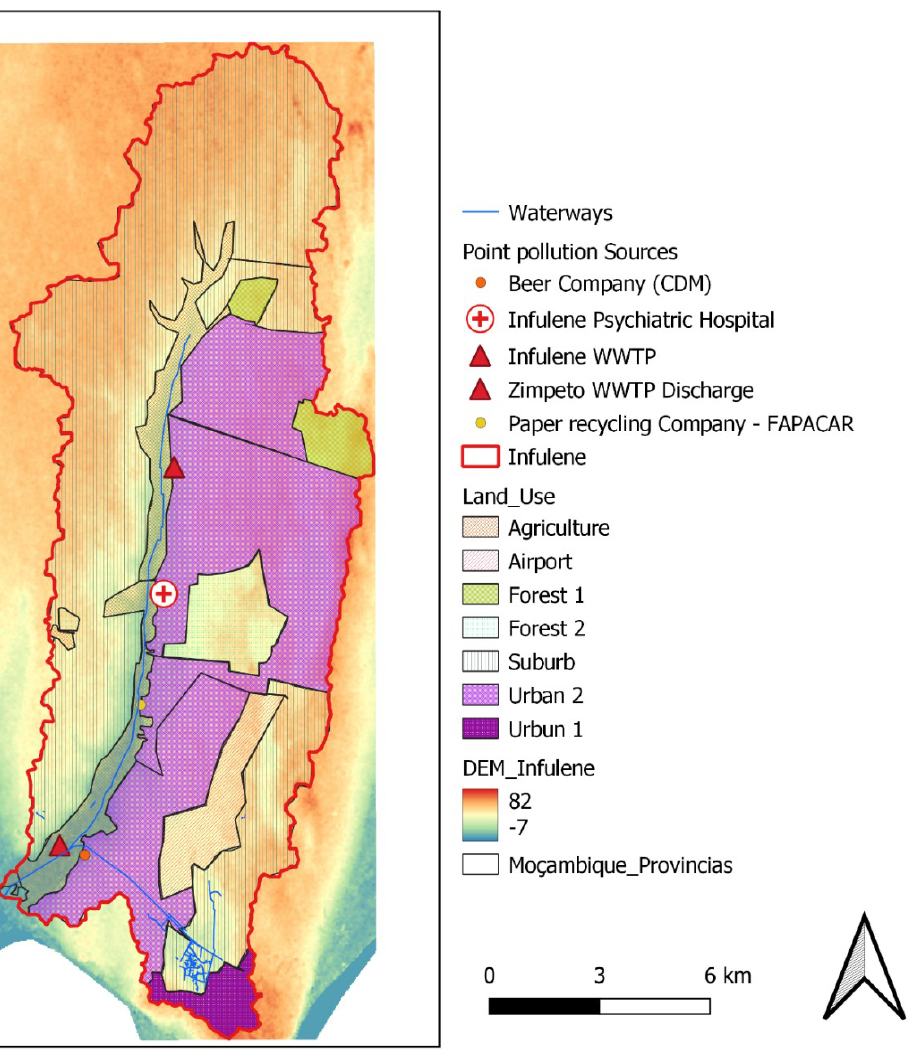
Figure 3. Main water point and defuse pollution sources identified .